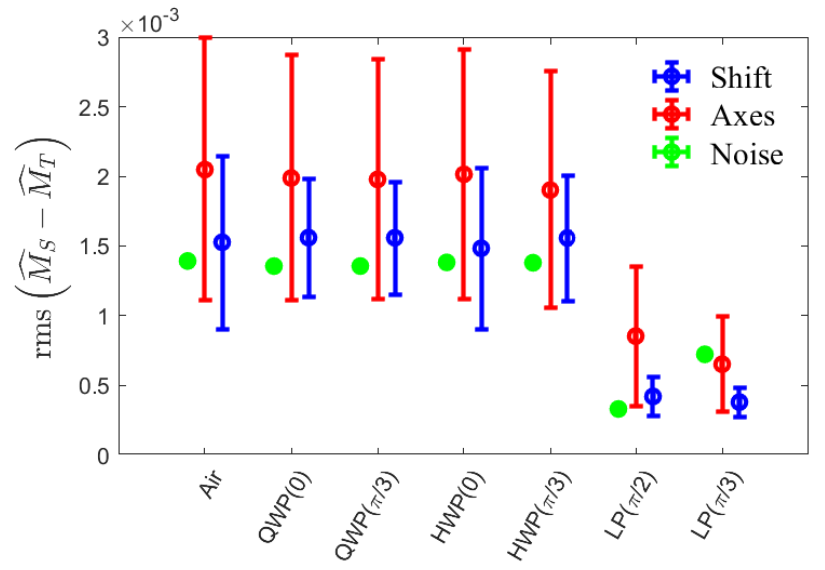
Figure 3. Mean values and standard deviations of the rms of the differences between the theoretical Mueller matrix and the calculated one from 500 realizations of the simulated experiment for different